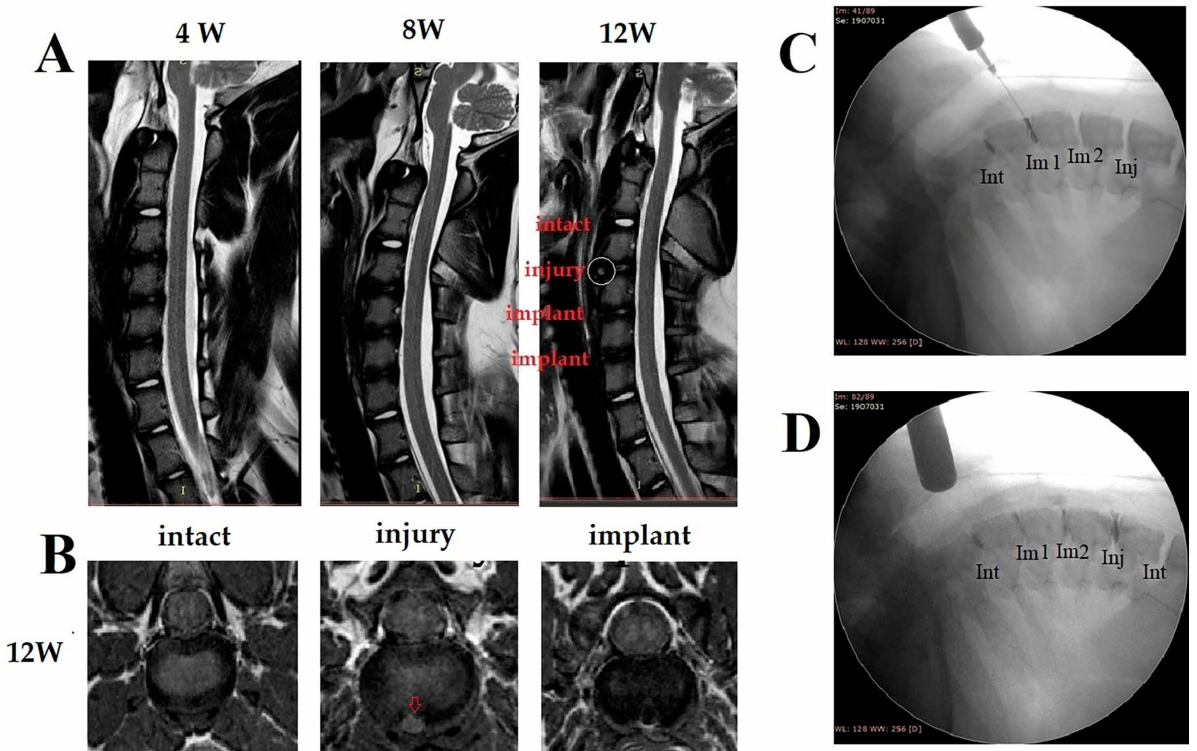
Figure 10. ( A ) T2-weighted MRI sagittal images at 4, 8, 12 weeks after surgery. The white circle indicates the formation of high intensity zone (HIZ) in injury group. ( B ) T2-weighted MRI axial images at 12 weeks after surgery. The red arrow indicates HIZ in injury group. HIZ was found within AF in injury control level at 12 weeks after the surgery, which indicated inflammation with possible peripheral vascular ingrowth. ( C , D ) shows the result of discography at 12 weeks after surgery. Type I (cotton ball appearance) in intact healthy disc (Int) and type III appearance (contained but irregular) in disc repaired with implant 1 (Im1) are shown in panel C. In injury group (Inj), after injecting contrast medium, immediate continuous leakage of contrast medium was shown which indicated failure of AF healing ( D